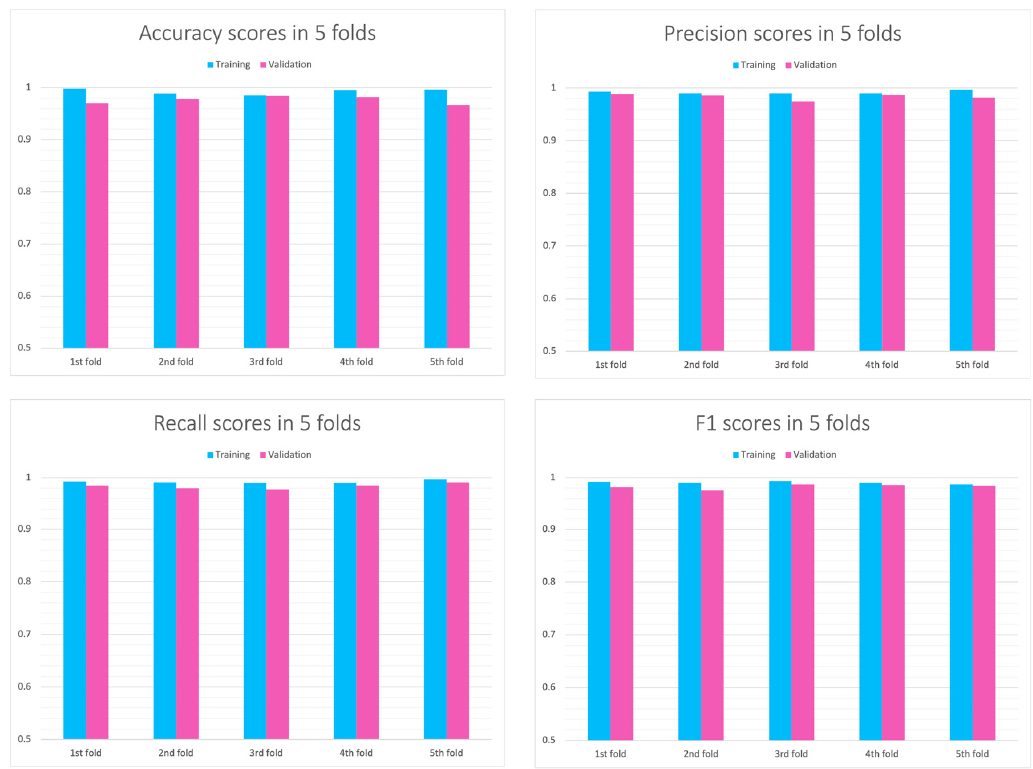
Figure 4. Results obtained for k-folds.